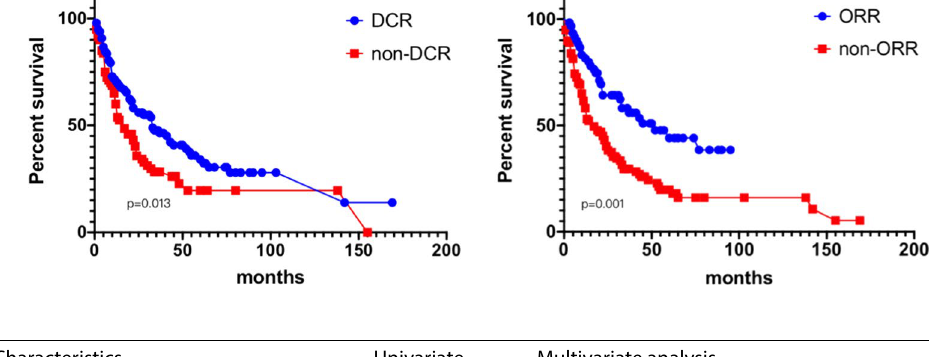
Table 4 Univariate and multivariate analysis of factors influencing 5-year